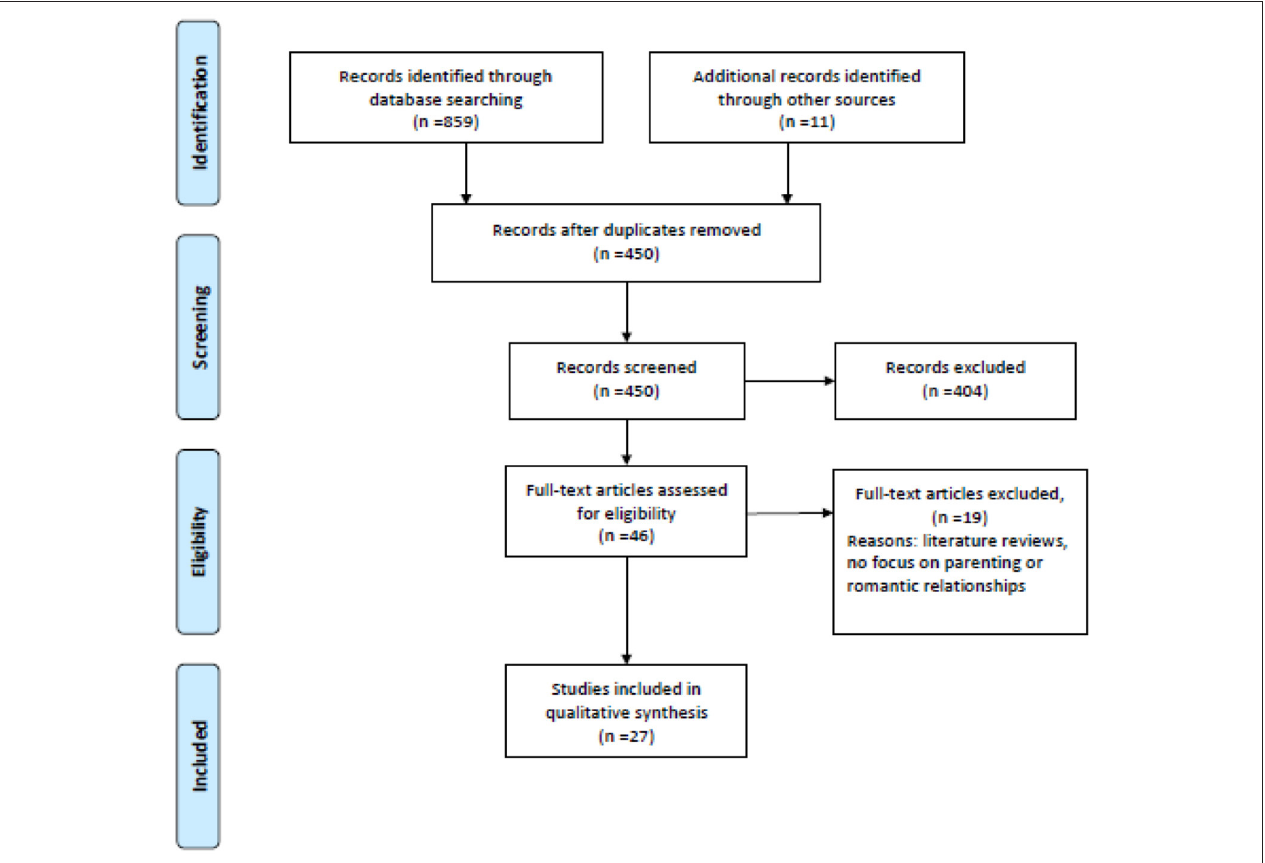
FIGURE 1 | Review process (PRISMA flow